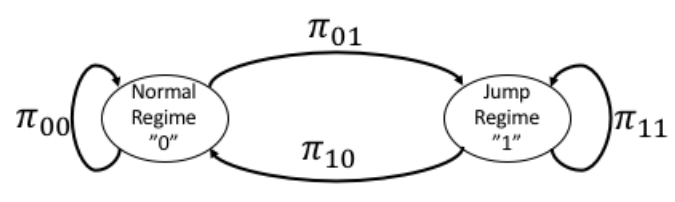
Figure 1. Markov regime switching